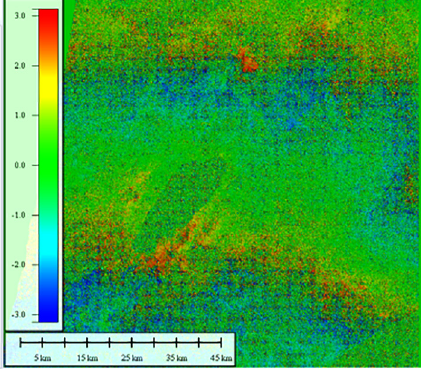
Figure 7. Phase unwrapping Dint